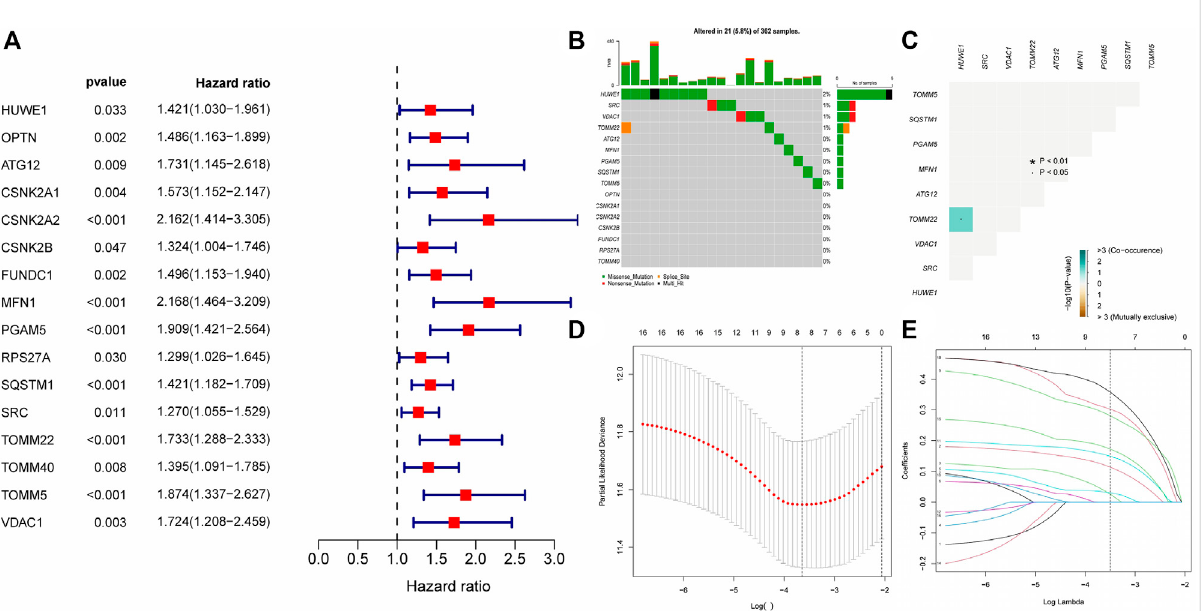
FIGURE 3 Gene mutation analysis and establishment of prognostic model (A) The result of Single factor COX regression The inclusion criteria were that the p value was less than 0.05 and the HR con fi dence interval did not include 1; (B) Waterfall map of gene mutation. (C) Co-mutation of 16 prognostic-related genes. Green represented that the mutation of one gene would promote the mutation of another gene. Brown indicated that onegenemutation inhibitsanothergenemutation; (D – E) TheLASSON regressionpunishedallvariables. The coordinates atthelowest pointof the red line in Figure D were the penalty values. A dotted line was drawn at the corresponding penalty value in Figure F, and all the independent variables that had great in fl uence on the dependent variables were selected (each curve represents the change trajectory of each independent variable coef fi cient).